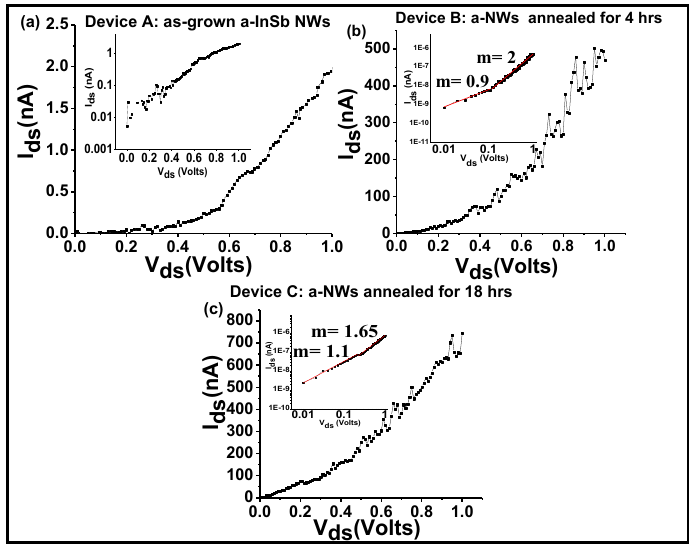
Figure 8. Current-Voltage curves of three devices comprising of single a - InSb NW, contacted by In-Au electrodes. ( a ) I-V curve of Device A showing non-linear behavior; the semi-log plot in the inset also shows a non-linear trend indicating that the contact is not a Schottky contact; ( b ) non-linear I-V curve of Device B; inset shows a linear log-log plot with two different slopes in the low bias ( m = 0.9) and high bias regime ( m = 2); ( c ) I-V plot of Device C showing the curve is becoming more linear as the material becomes more crystalline with long-duration anneal. At low bias, all three plots obey Ohm’s law. At high bias voltage, the plots follow I α V m where the values of m varying from 3.1 to 1.6. The decreasing values of m as the InSb NWs are annealed for longer time periods verifies the efficacy of heat treatment for transforming a - InSb to c - InSb